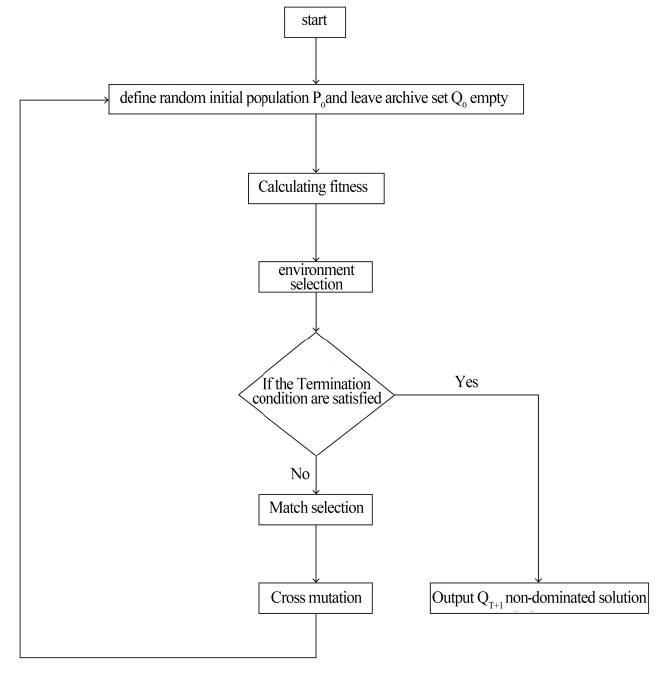
Figure 8. SPEA-II work flow.